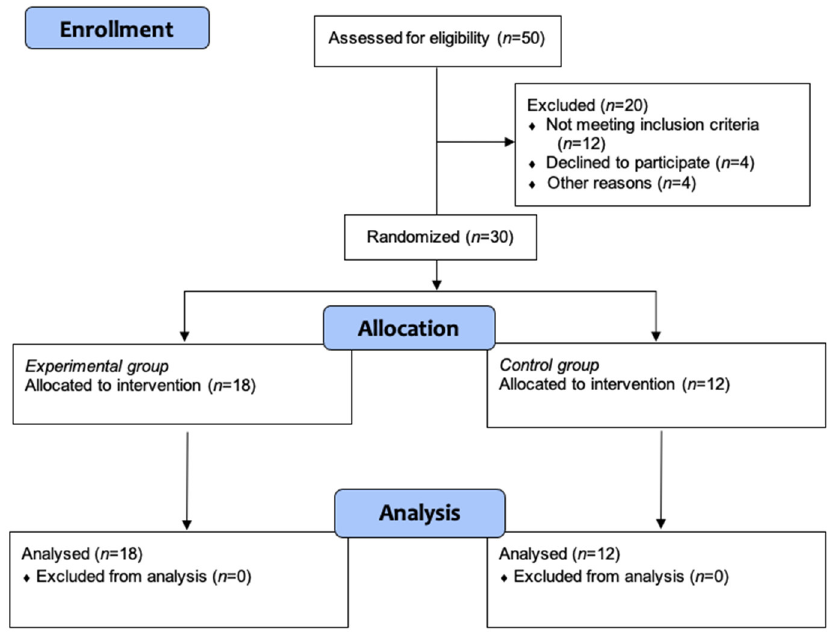
Figure 1. Study Figure 1. Study flowchart.